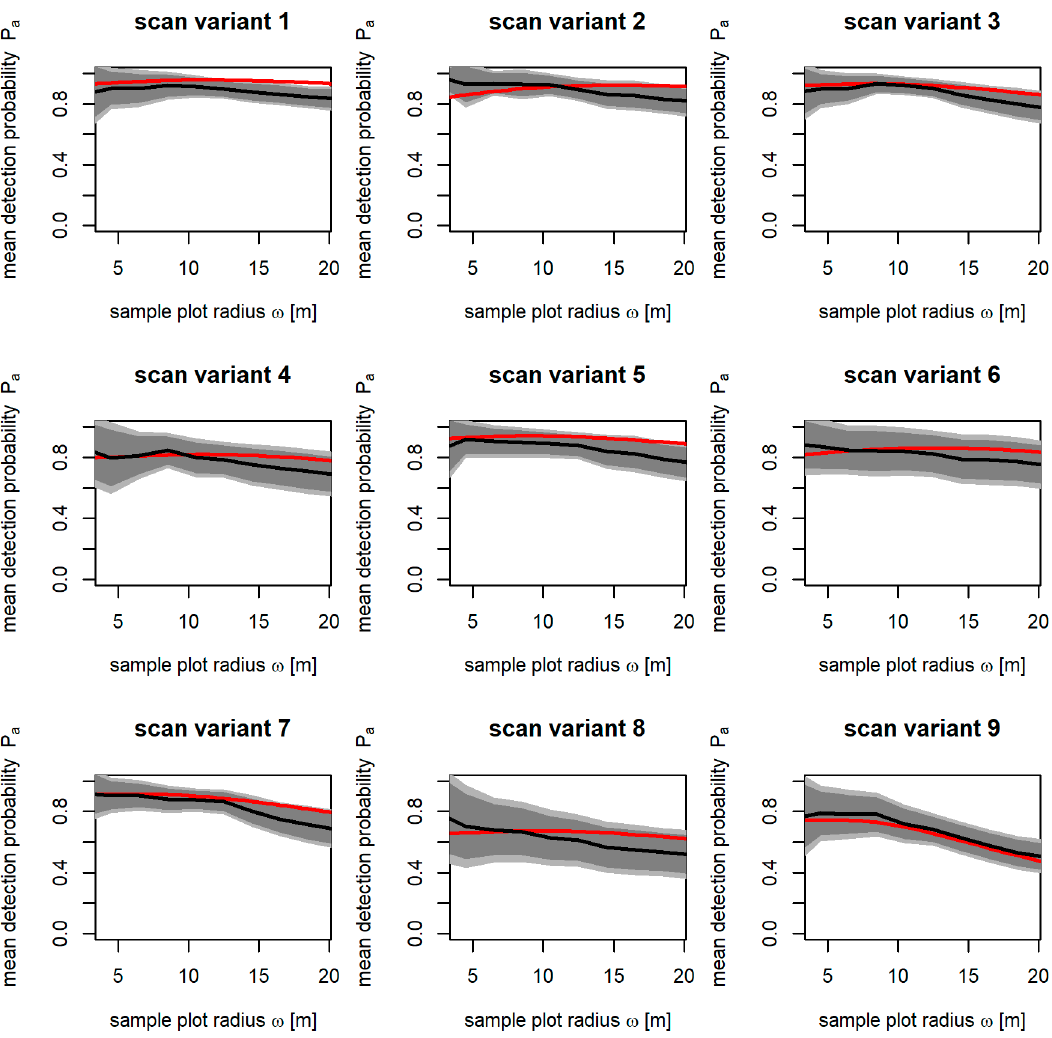
Figure A4. Mean detection probability P a of large trees (dbh ≥ 20 cm) for di ff erent sample plot radii ω and all scan variants described by Gollob et al. [43]. The black line represents the observed data; the red line represents the model prediction. The light and dark grey areas are the 99% and 95% confidence intervals computed from the observed data, respectively.